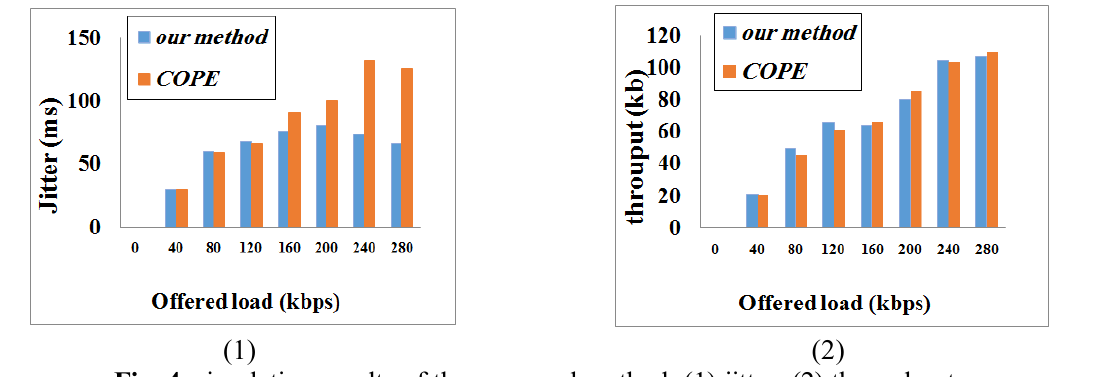
Fig. 4. simulation results of the proposed method: (1) jitter, (2)